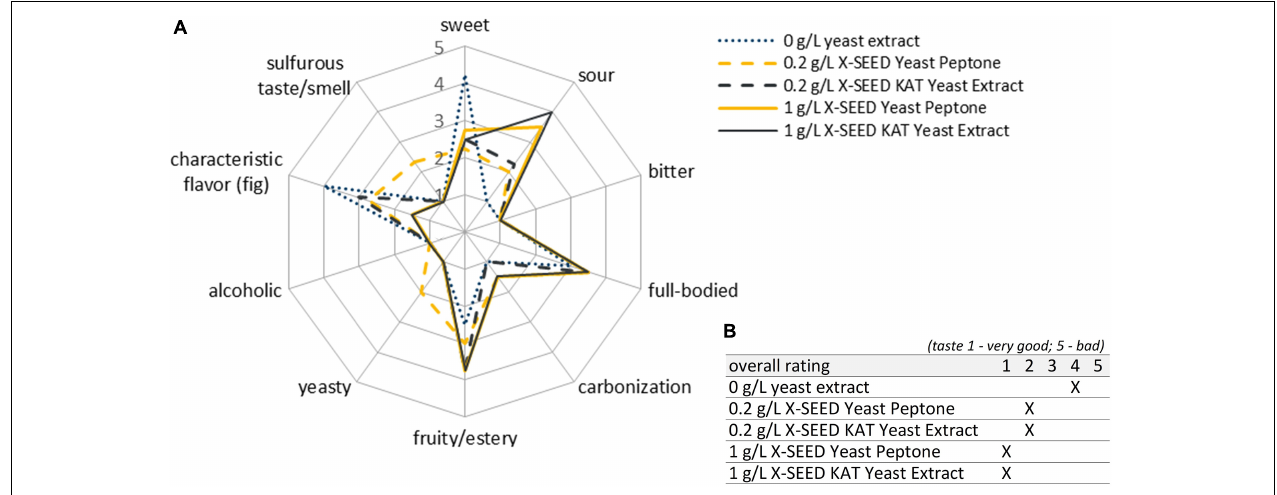
FIGURE 7 | Sensory properties of the products fermented with the microbial combination Leu + Han under the investigation of 0, 0.2, and 1 g/L of two different YEs after 7 days of fermentation. Shown are the mean data of two samples produced in biological duplicates. The rating scale of the descriptive analysis (A) ranges from 1 (imperceptible) to 5 (very pronounced). The overall rating of the taste (B) ranges from 1 (very good) to 5 (bad taste). YE, yeast